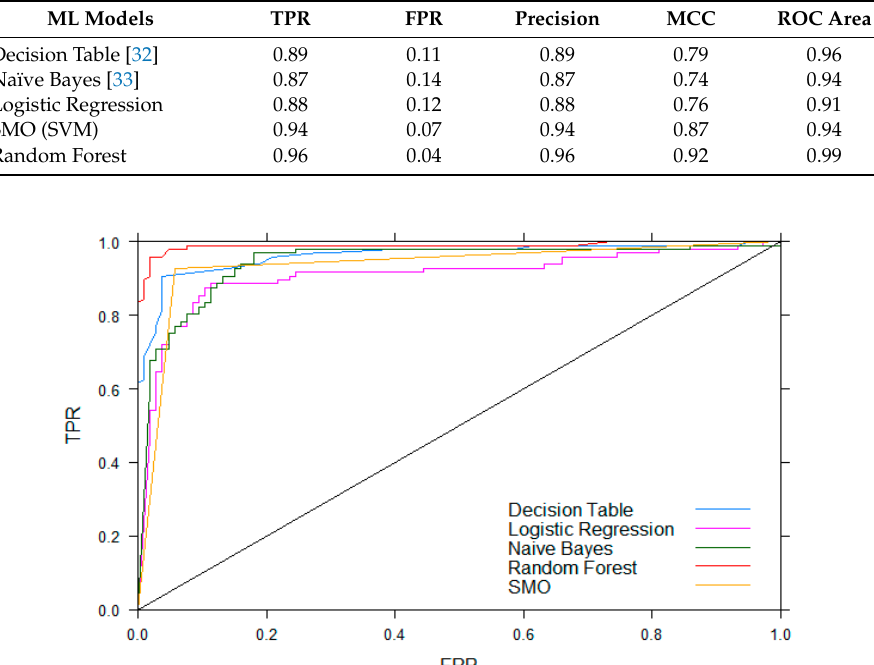
Figure 7. Receiver operating characteristic (ROC) curves of each algorithm. ROC curves plot the false positive rate (FPR) versus the true positive rate (TPR). Therefore, the closer the ROC curve is to the upper left corner, the higher the overall accuracy of the model.